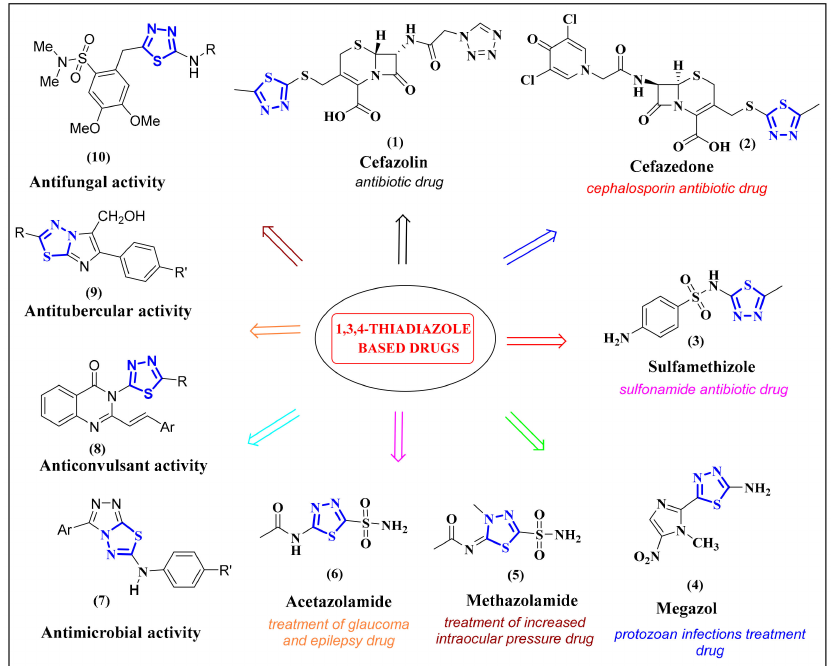
Figure 1. Examples of the 1,3,4-thiadiazole motif in several drugs and promising potential agents and its usefulness in chemical and bioactive